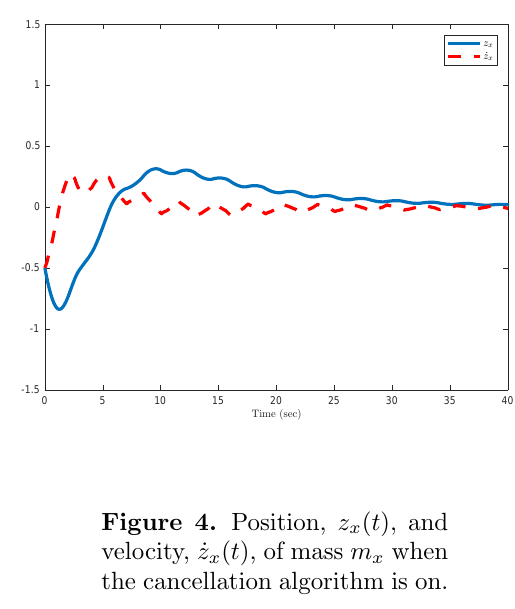
Figure 4. Position, z x ( t ), and velocity, ˙ z x ( t ), of mass m x when the cancellation algorithm is on.